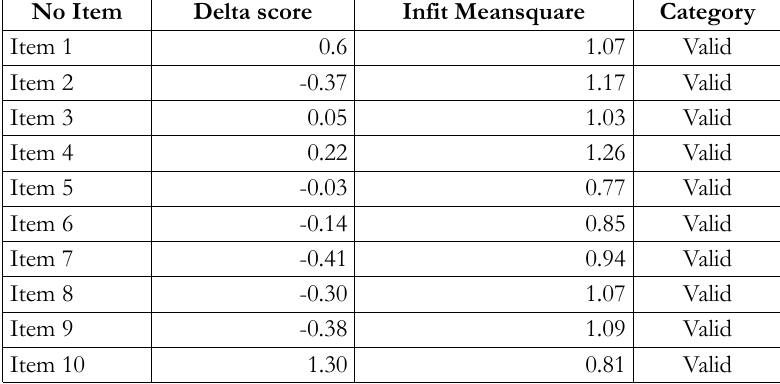
Table 10. Result of item empirical test